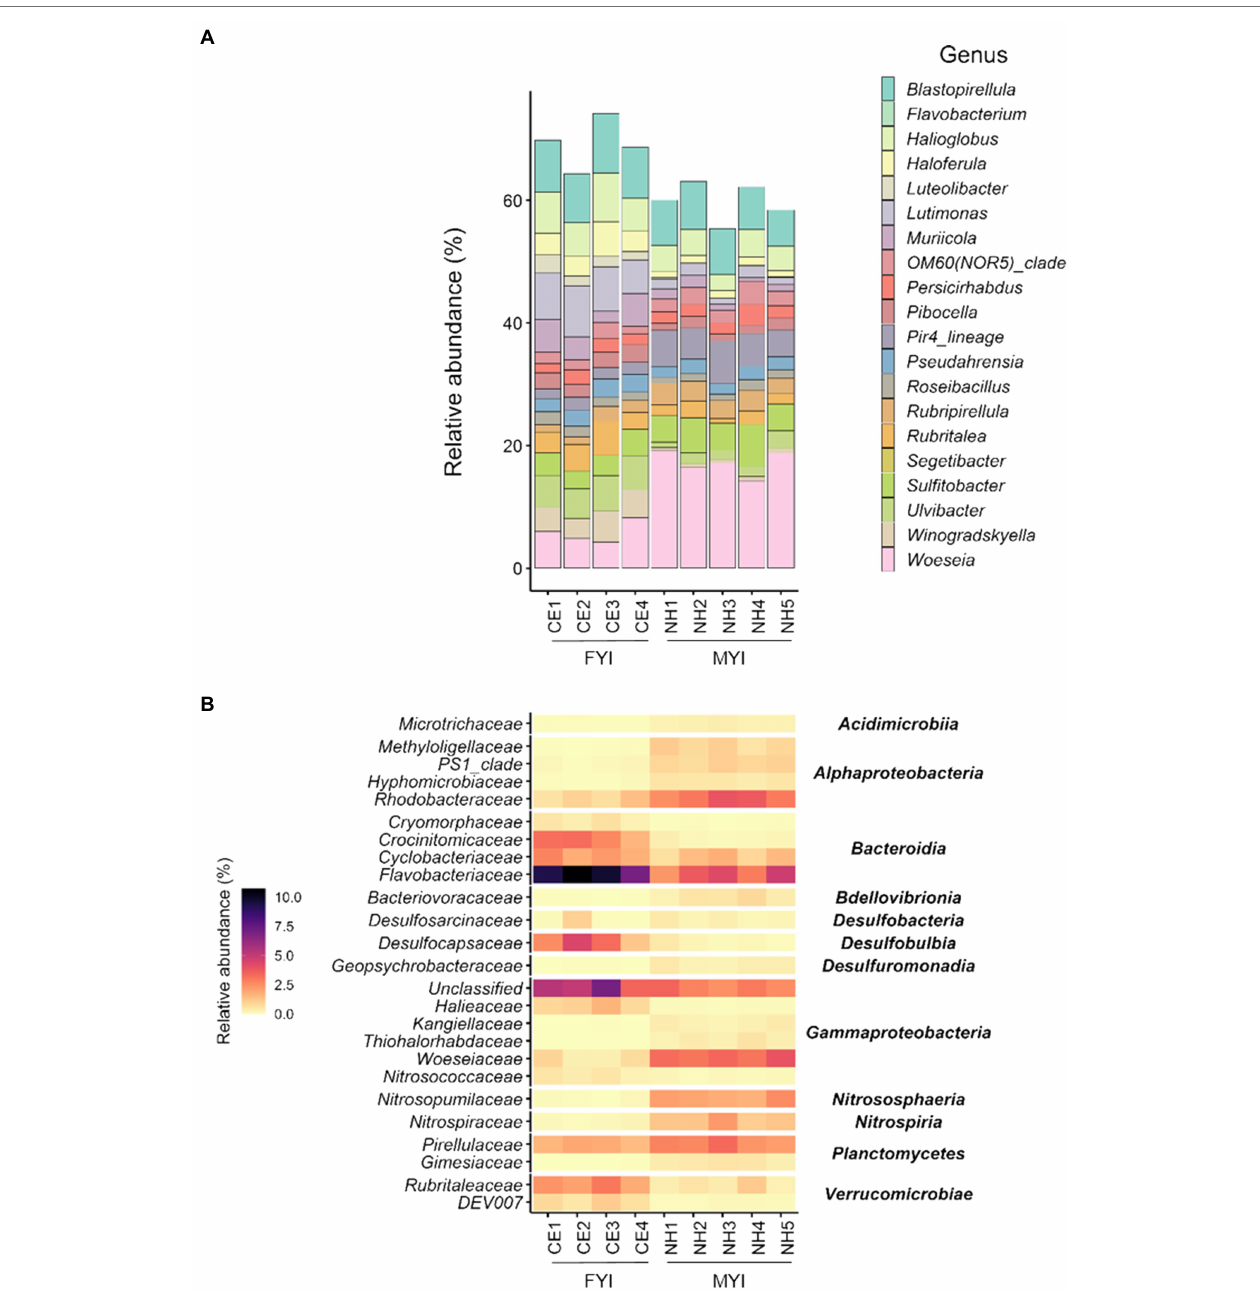
FIGURE 2 | Microbial community composition at the level of genus (A) in surface sediment samples from Cape Evans (CE) and New Harbour (NH). Differentially abundant taxa identified by ANCOM (analysis of composition of microbiomes; (B) in surface sediment samples from Cape Evans and New Harbour, with p > 0.05 and relative sequence abundance >1.5%, visualized in a heatmap at the taxonomic level of family (left column) and order (right